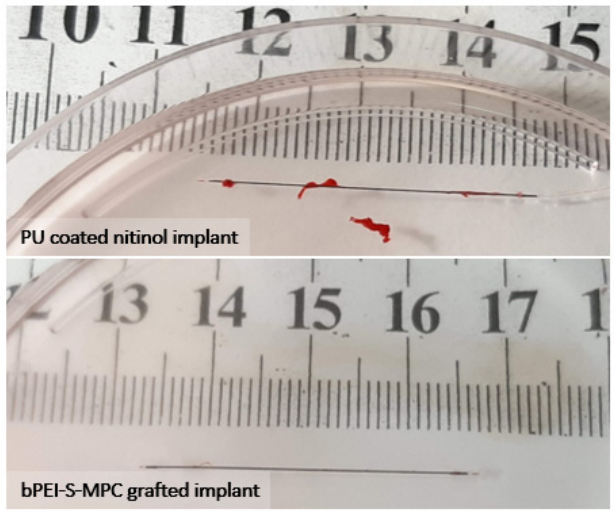
Figure 7. Implants after 3 h implantation in rabbit femoral artery. Implants that were grafted with bPEI-S-MPC showed significant antithrombogenic potential (average score 1.3, n = 3) compared with a PU-coated implant (average score 3.3, n = 3).